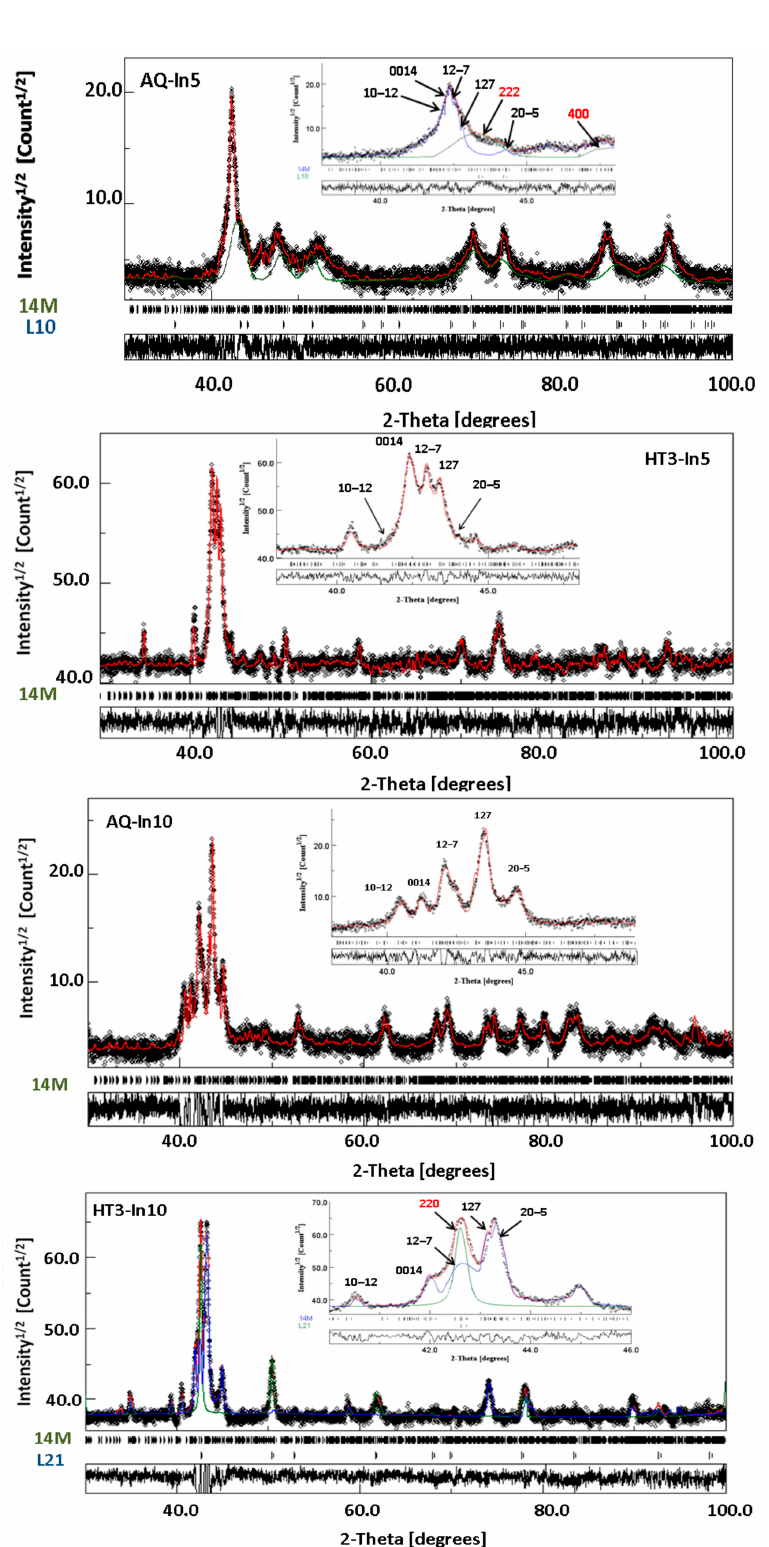
Figure 2 Figure 2. Rietveld refinement of the XRD patterns of the as quenched (AQ-In5 and AQ-In10) and heat- treated (HT3-In5 and HT3-In10) samples. The difference between the measured (dots) and calculated (line) patterns is shown below (Diff.). The reliability factors are G of = 1.2, Rwp(%) = 25.17, Rb(%) = 19.06, and Rexp(%) = 22.27 for AQ-In5; G of = 1.4, Rwp(%) = 3.94, Rb(%) = 2.87, and Rexp(%) = 1.95 for HT3- In5; G of = 1.35, Rwp(%) = 3.25, Rb(%) = 2.3, and Rexp(%) = 2.32 for AQ-In10; Gof = 1.26, Rwp(%) = 4.6, Rb(%) = 3.14, and Rexp(%) = 2.6 for HT3-In10. The insets show the enlargement of the 2 θ range of 39–46 ◦